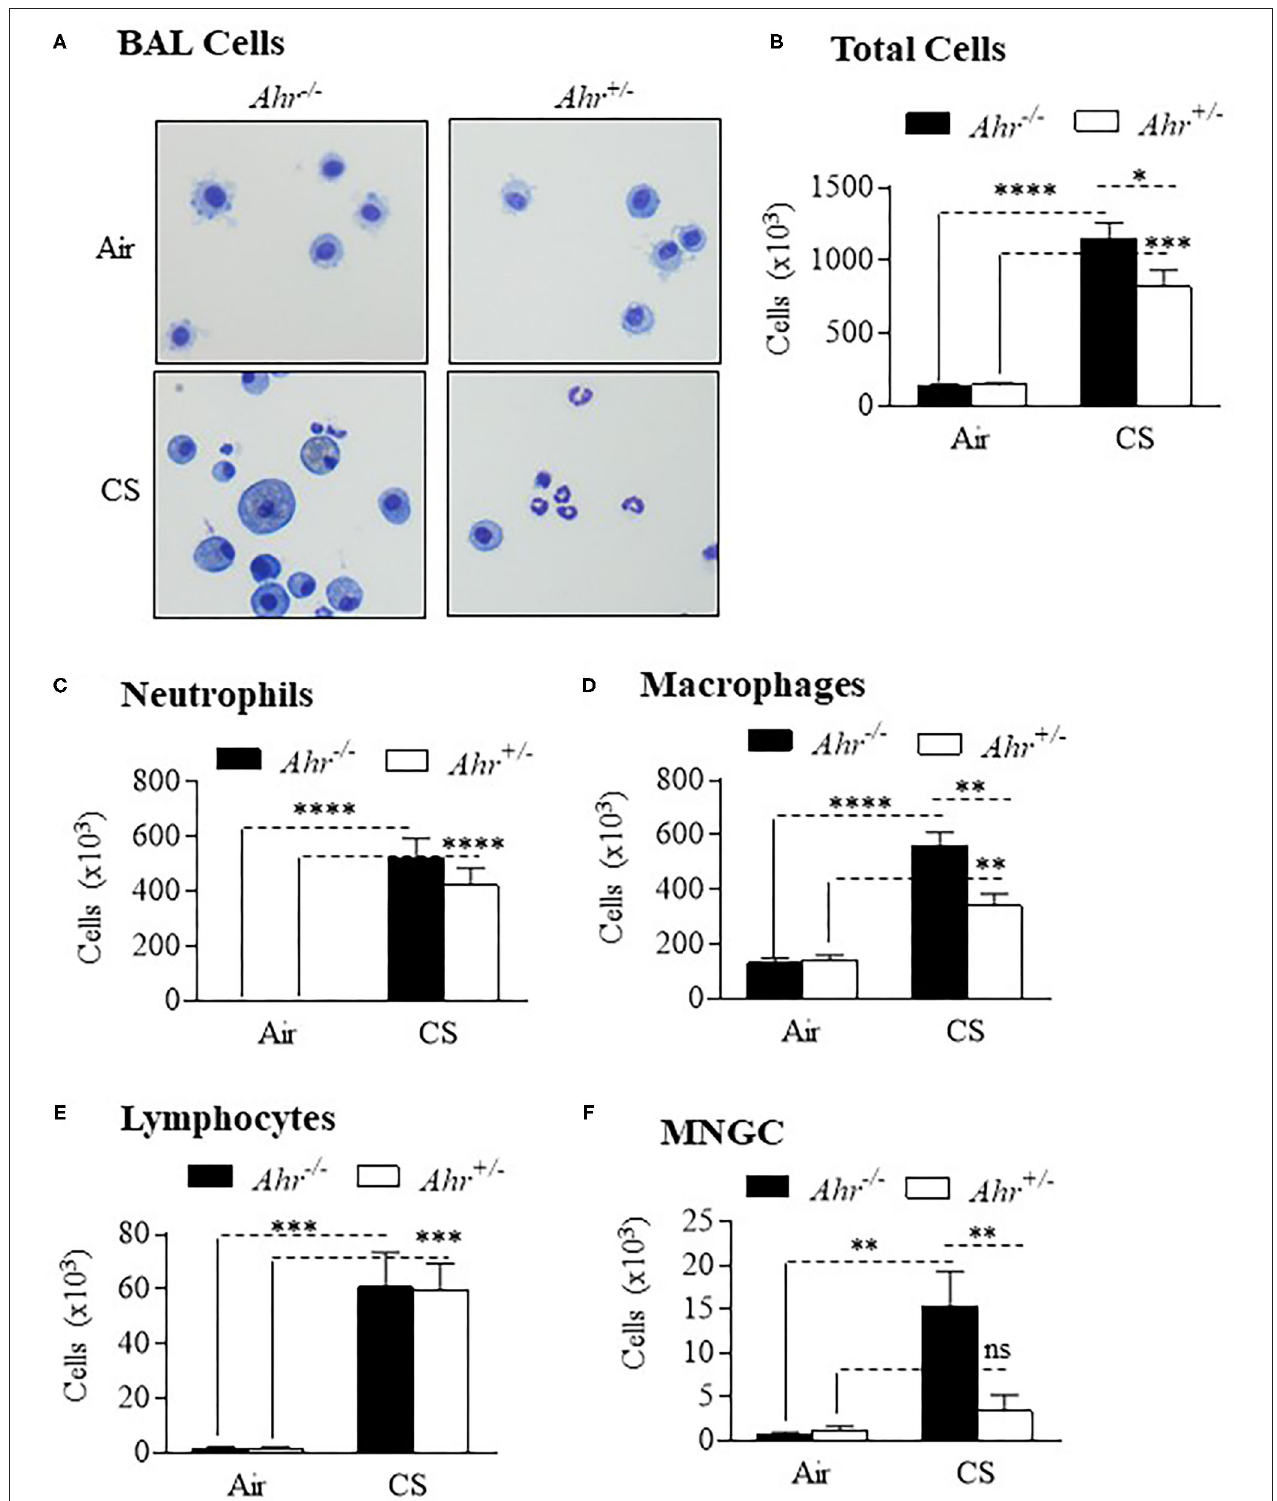
FIGURE 1 | AhR deficiency results in heightened pulmonary inflammation in response to an 8-week cigarette smoke (CS) exposure regime. (A) BAL Cells- Representative images of cells from the BAL of Ahr + / − and Ahr − / − mice exposed to an 8-week CS regime. (B) Total Cells- There was a significant increase